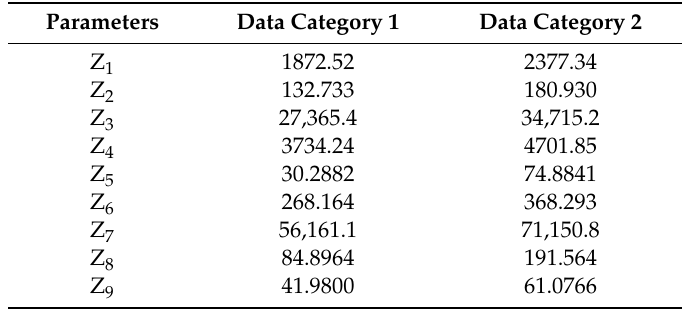
Table 4. Comparison of the average µ * values between the two supports.